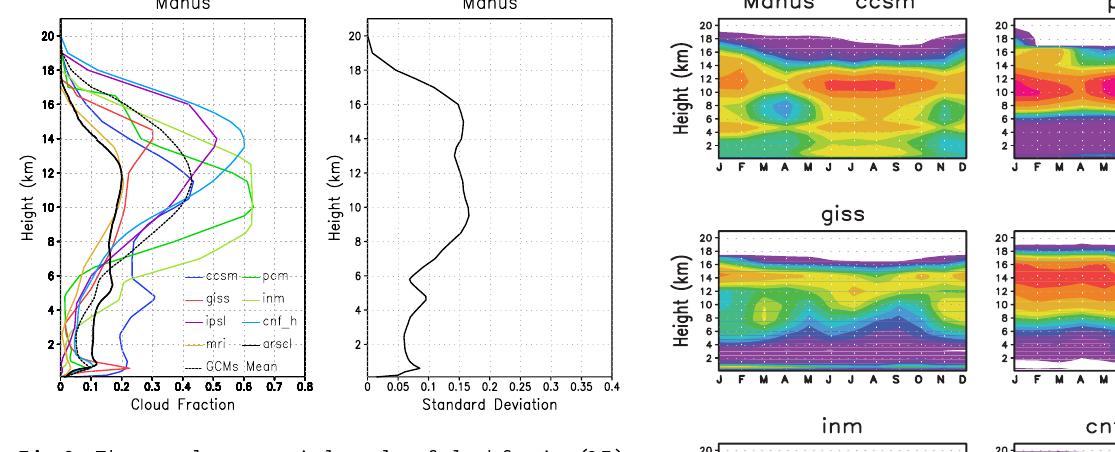
Fig. 9. The annual mean vertical profiles of cloud fraction (CF) from ARSCL observation and GCMs (left) and their standard de- viation in seven GCMs (right) over Manus. The GCM results for 1980–1999 and ARSCL observation for 1999–2008 are used in cli- matology average.